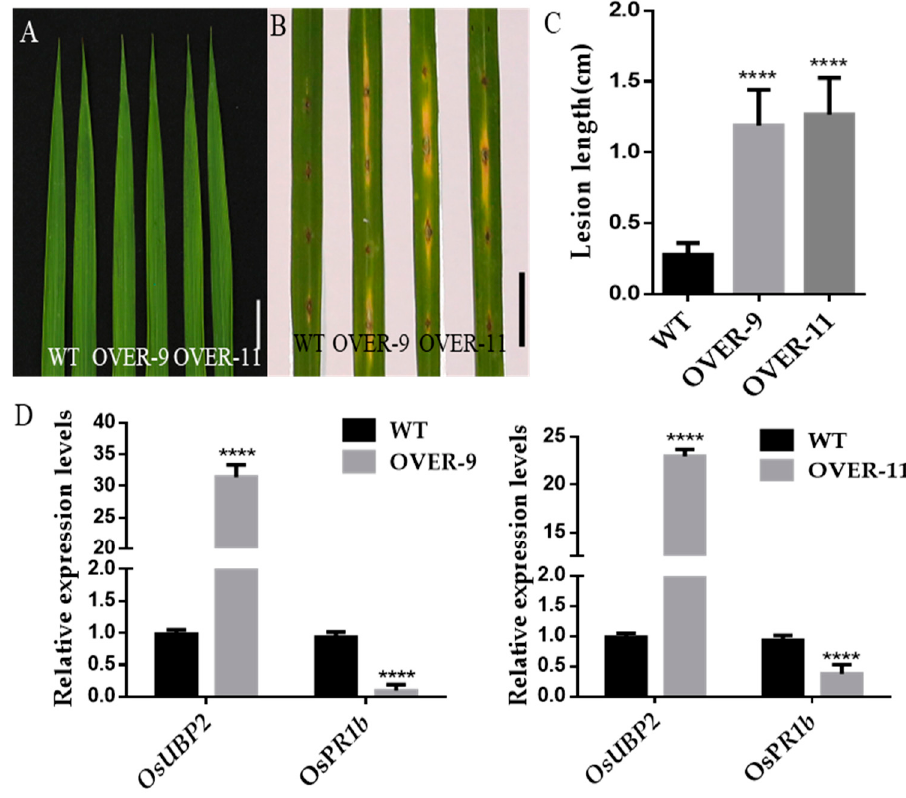
Figure 6. Disease resistance phenotype of OsUBP2 overexpression plants. ( A ) Leaves of WT and OsUBP2 overexpression plants at the heading stage. Bar = 2 cm. ( B ) Punch inoculation of OsUBP2 overexpression plants and WT plants with the compatible M. Oryzae isolate RB22, Leaves were photographed at 7 dpi. Scale Bar = 2 cm. ( C ) Lesion area of the inoculated leaves of OsUBP2 overexpression plants and WT plants shown in ( B ) at 7 dpi. Error bars represent + SD ( n = 9). ( D ) Relative expression levels of OsUBP2 and OsPR1b in two overexpression lines. Data were normalized to the expression level of the reference gene OsACTIN . Error bars represent +SD ( n = 6 independent pools of leaves, two plants per pool). Asterisks indicate a significant difference between the OsUBP2 overexpression and WT plants by Student’s t-test: **** p < 0.0001.